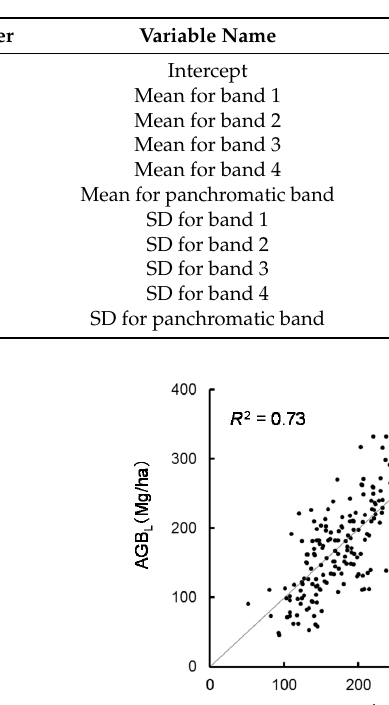
Table 6. The results of the multiple-regression analysis in the model in Equation (3) using the AGB L values predicted by the LiDAR model and the mean and standard deviation of the reflectance values in each band of satellite data for all objects. α 0 represents the intercept; β k and γ k are the regression coefficients for the mean and standard deviation (SD) (respectively) for band k , with k = 5 representing the panchromatic data.